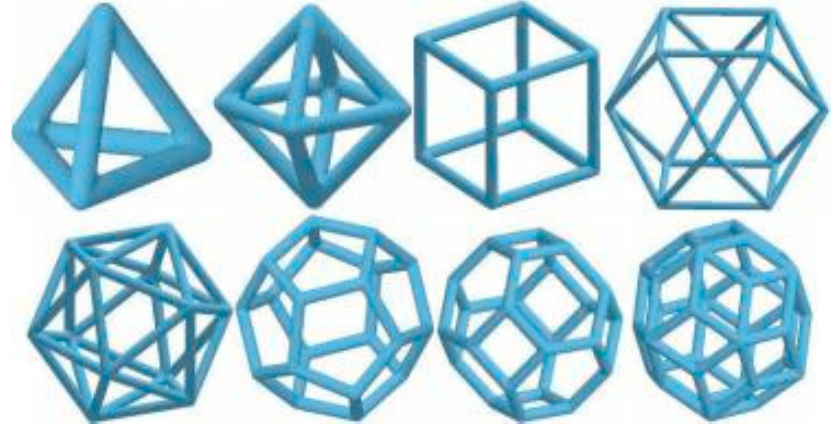
Figure 12. 3D unit cell structure library [157]: tetrahedron, octahedron, cube, vector ( top row , from left to right); icosahedron, dodecahedron, tetrakaidecahedron, triacontahedron ( bottom row , from left to right).